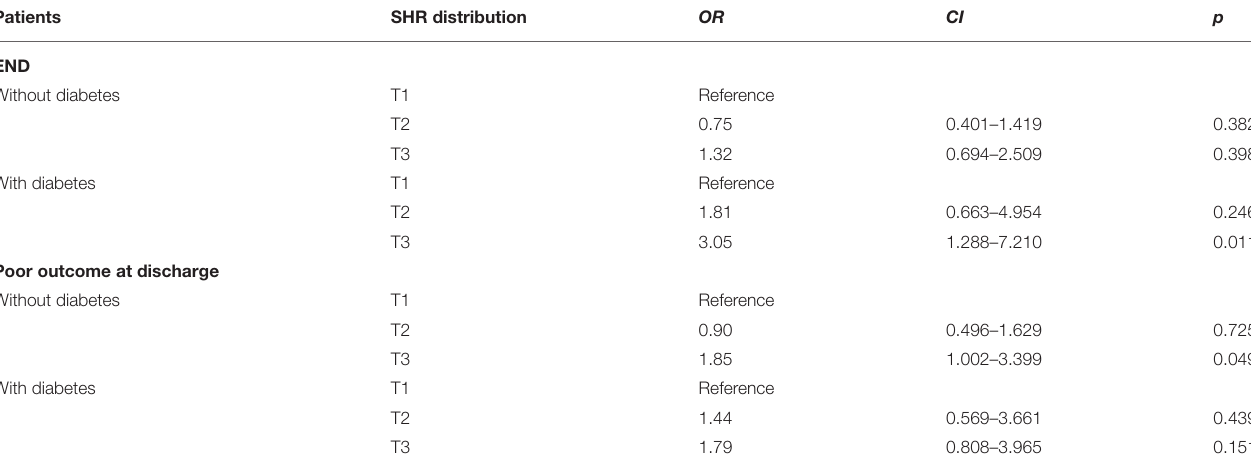
TABLE 4 | Multivariate logistical regression analyses depicting the association of SHR and END in the patients with and without diabetes.